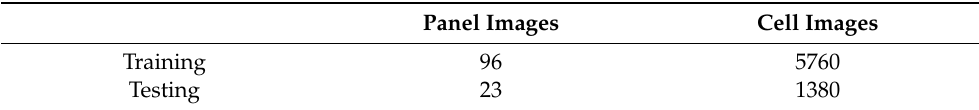
Table 1. The EL image dataset.